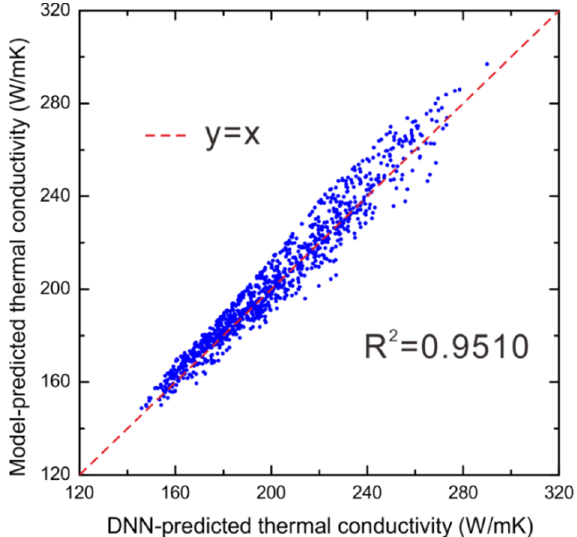
Figure 7. The comparison between the DNN-predicted thermal conductivities and the evaluated ones by the physical model for the WC-Ag system. ones by the physical model for the WC-Ag